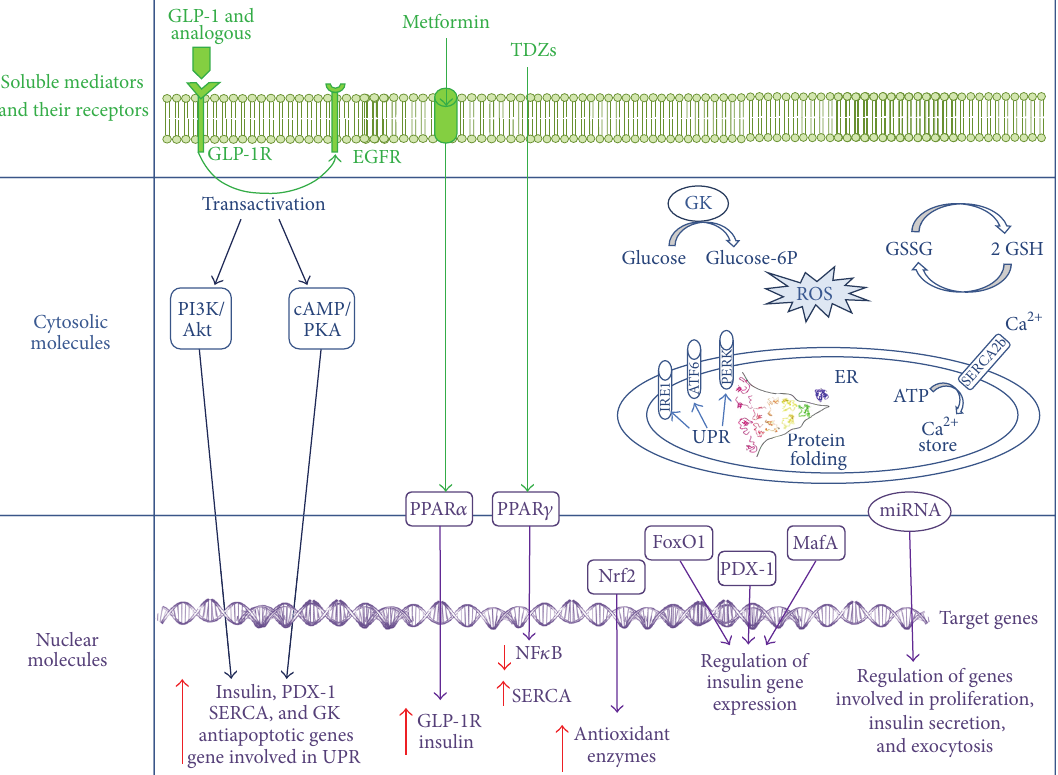
Figure 1: Intracellular effects of soluble mediators are mainly mediated through the interaction with specific receptors that link extracellular signals up to modulation of gene expression. GLP-1 signaling pathway is activated after the binding to its receptor, GLP-1R, and subsequent transactivation of the EGFR. GLP-1’s effects on beta-cell are mainly mediated by the cAMP signaling pathway. GLP-1 potentiates glucose- induced insulin secretion, improves the function of pancreatic beta-cells by promoting neogenesis and proliferation and by decreasing apoptosis signals, increases antioxidant defense, promotes insulin gene transcription, mRNA stability, and biosynthesis, and increases the expression of Pdx-1 and the binding of Pdx-1 to the insulin promoter. Exendin 4, a GLP-1R agonist, potentiates expression of gene products subjectedtotheUPRinresponsetoERstress,stimulatesGKexpression,andpreventsdepletionofSERCAexpression. Metformin enhancesthe expression of GLP-1R, via a peroxisome proliferator-activated receptor- (PPAR-) 𝛼 -dependent mechanism, and improves the responsiveness to incretins. The thiazolidinediones (TDZs) act by activating the nuclear receptors PPAR 𝛾 . TDZs preserve pancreatic beta-cell mass and improve their function, prevent NF- 𝜅 B activation, improve insulin secretory capacity in patients with diabetes, protect human islets against apoptosis, and maintain the homeostasis of intracellular Ca 2+ preventing the loss of SERCA. Extracellular signaling is mediated by cytosolic moleculeswhichcanbeenzymes,ions,andsoon.The PI3K/Akt signalingisaconvergingpathwayintheregulationofbeta-cellmassbygrowth factors, insulin, incretins, and glucose. The health of the beta-cell is also related to the maintenance of its homeostasis during its intensive function.The UPR restoresERhomeostasisbydecreasingERproteinloadandincreasingERfoldingcapacity.IntracellularCa 2+ concentration is important for GSIS, and also for ER function. The enzyme GK , which is considered a “glucose sensor” in pancreatic beta-cells, regulates pancreatic beta cell mass as well as their function. The temporally fluctuating activation of stress signaling is required for the maintenance of beta-cell survival, whereas its persistent activation results in beta-cell dysfunction and apoptosis. Indeed, ROS generation is not only a harmful process but, rather, plays a substantial role in the normal insulin signal transduction and is one of the metabolic signals stimulating insulin secretion. The ROS levels need to be finely regulated to keep good radicals from going bad thus avoiding oxidative damages. The ratio of the oxidized form of glutathione (GSSG) and the reduced form (GSH) is a dynamic indicator of the oxidative stress. The cellular adaptive response to oxidative stress is finely regulated by Nrf2 , which upregulates transcription of antioxidant and phase II detoxification enzymes. Regulation of gene transcription is regulated at different biological levels. Recently, miRNAs target genes emerged important for pancreas development, beta-cell proliferation, insulin secretion, and exocytosis. Interestingly, as expression of the transcription factors implicated in the regulation of insulin transcription, such as MafA , Pdx -1, and FoxO 1, are controlled by the relationship between themselves for instance, FoxO1 and PDX-1 bind directly to the MafA promoter and mediate MafA transcription, and transcription of the gene coding for PDX-1 is negatively regulated by the binding of FoxO1 to the PDX-1